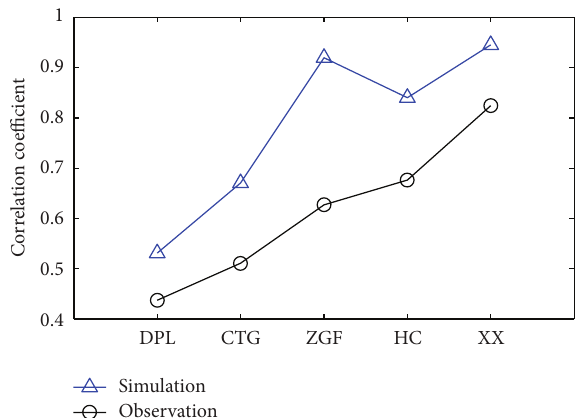
Figure 14: The correlation coefficient between the streamflow at the catchment outlet (HB station) and that at the five interior gauges (DPL, CTG, ZGF, HC, and XX station) for both observation and model